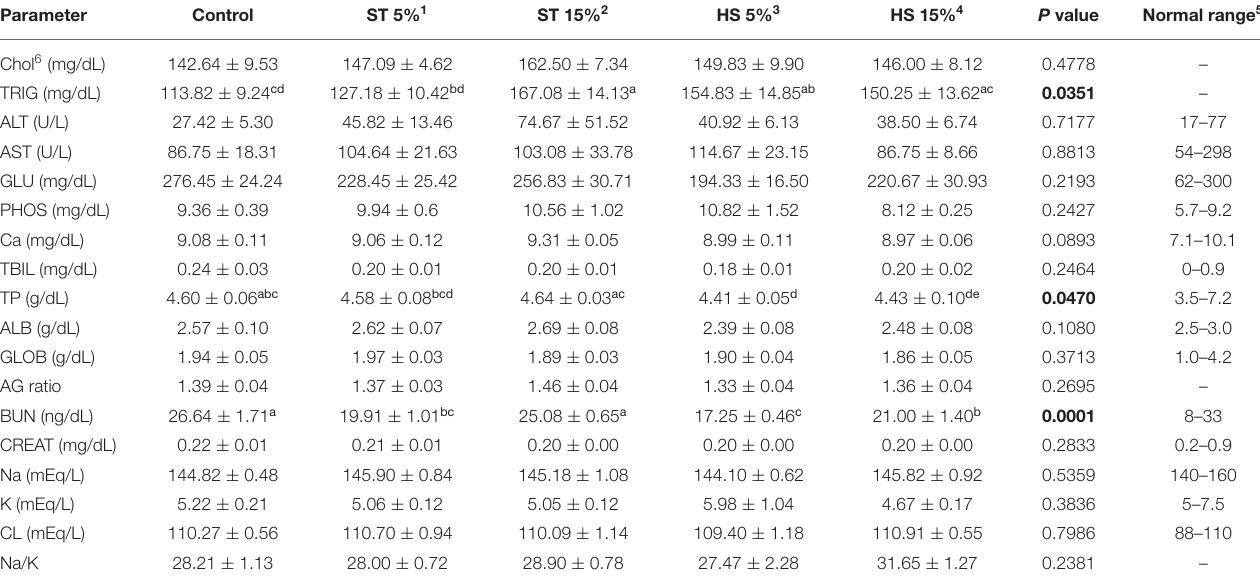
TABLE 1 | ‘HoneySweet’ study blood chemistry for males.